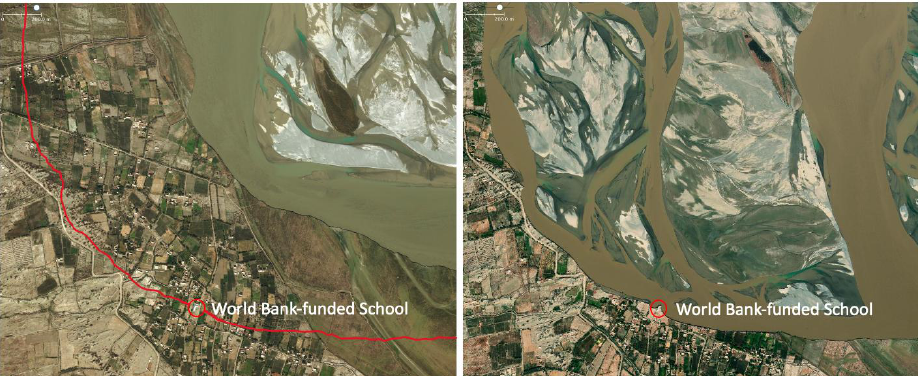
Figure 1. The location of a school in Afghanistan before and after a flood (Satellite imagery: ESRI). This flood of the Amu Darya river occurred in April 2018.